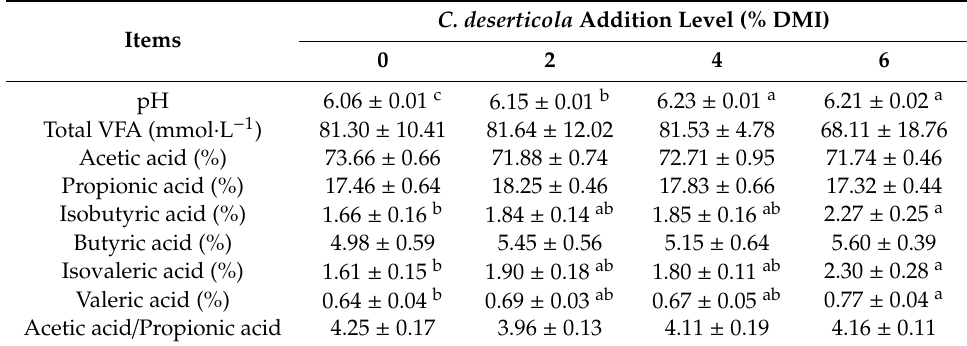
Table 5. E ff ect of C. deserticola addition on rumen fermentation parameters (mean ± SE).